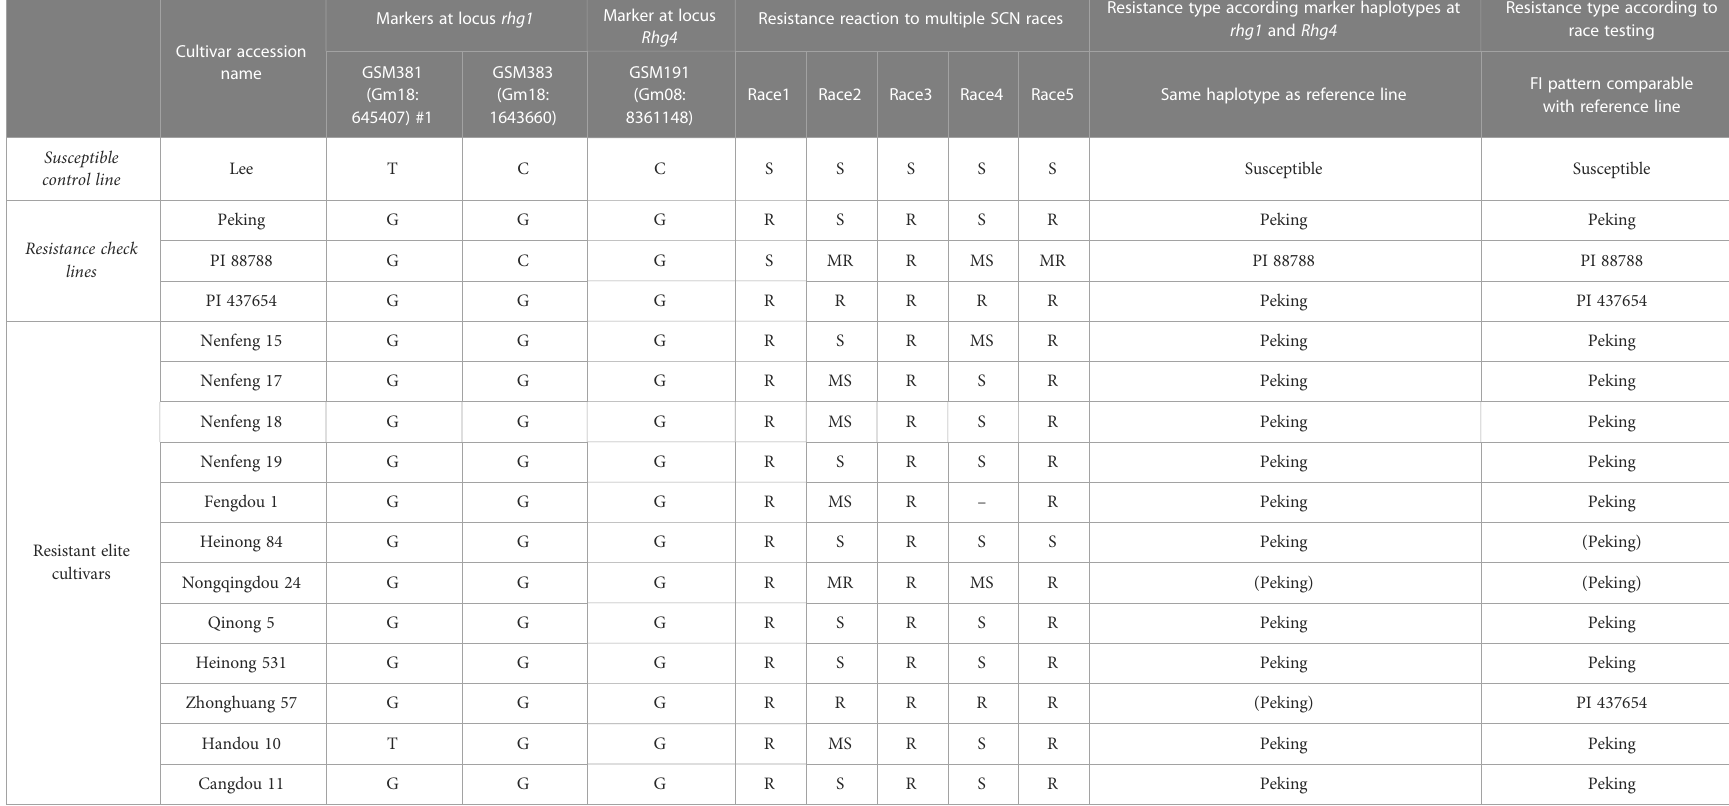
TABLE 3 Marker haplotypes at SCN loci rhg1 and Rhg4 , race testing phenotypes, and the corresponding resistance types of the 12 soybean cultivars and four known soybean reference lines.